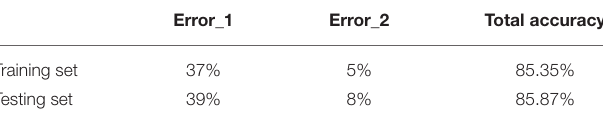
TABLE 3 | Prediction performance using BMI, TC, HDL-C, and LDL-C as factors.